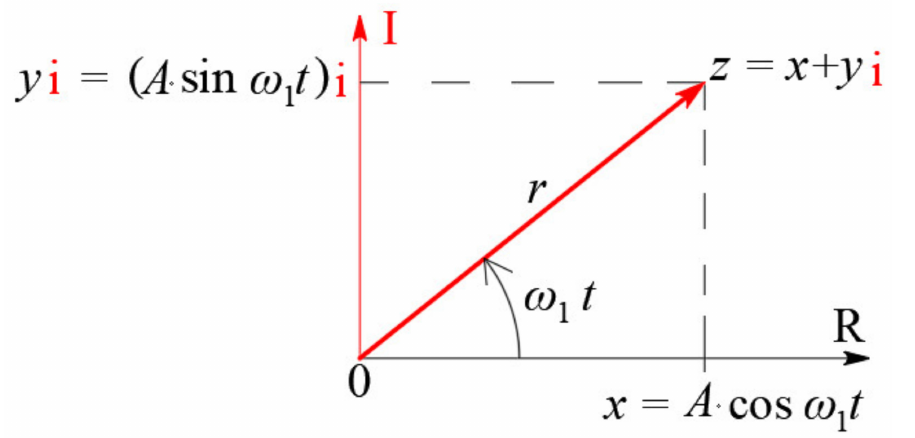
Figure 2. The complex vector of